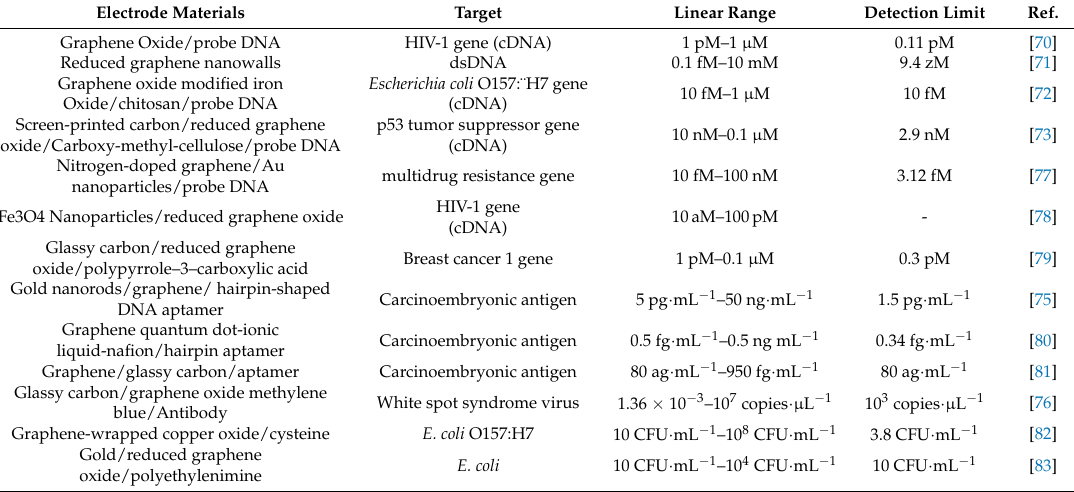
Figure 5. Schematic illustration for the development of electrochemical white spot syndrome virus immunosensor using a methylene blue dye (MB) immobilized graphene oxide modified glassy carbon electrode. Reproduced with permission from [76], Copyright Springer Nature, 2017. Table 3. Comparison of different graphene-based electrode for protein/nucleic acid detection.